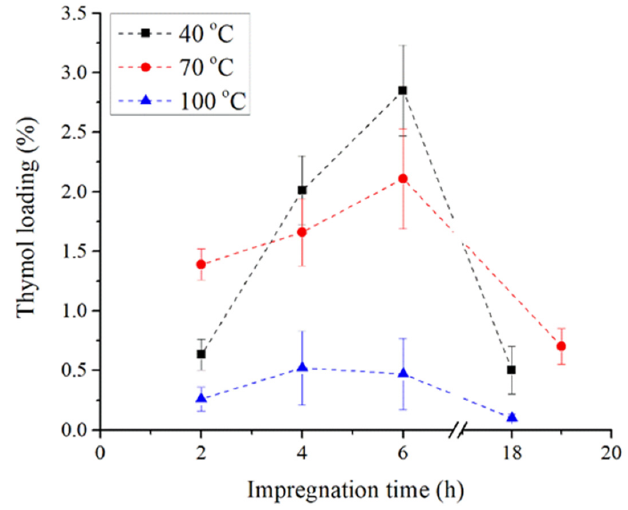
Figure 1. Kinetic of thymol loading into TPS.